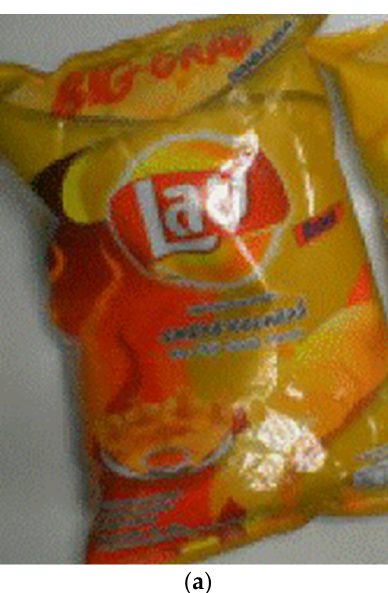
Figure 5. Images transformed using Haar and Daubechies wavelets: ( a ) using a Haar ‐ based wavelet and ( b ) using a Daubechies wavelet.